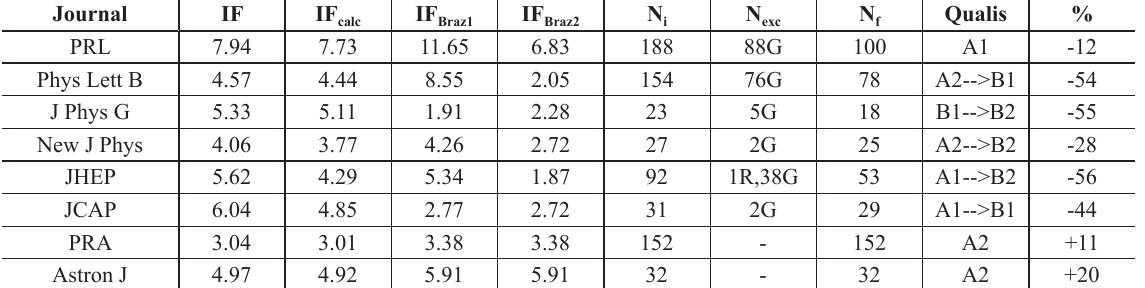
2-year 2012 impact factor of some selected physics journals. N papers, N the number of papers excluded (G for group-authors and R for reviews) exc and N =N -N is the number of papers considered for the statistics. The acronyms, in f i exc decreasing order, mean Physical Review Letters, Physics Letters B, Journal of Physics G, New Journal of Physics, Journal of High Energy Physics, Journal of Cosmology and Astroparticle Physics, Physical Review A and Astronomical